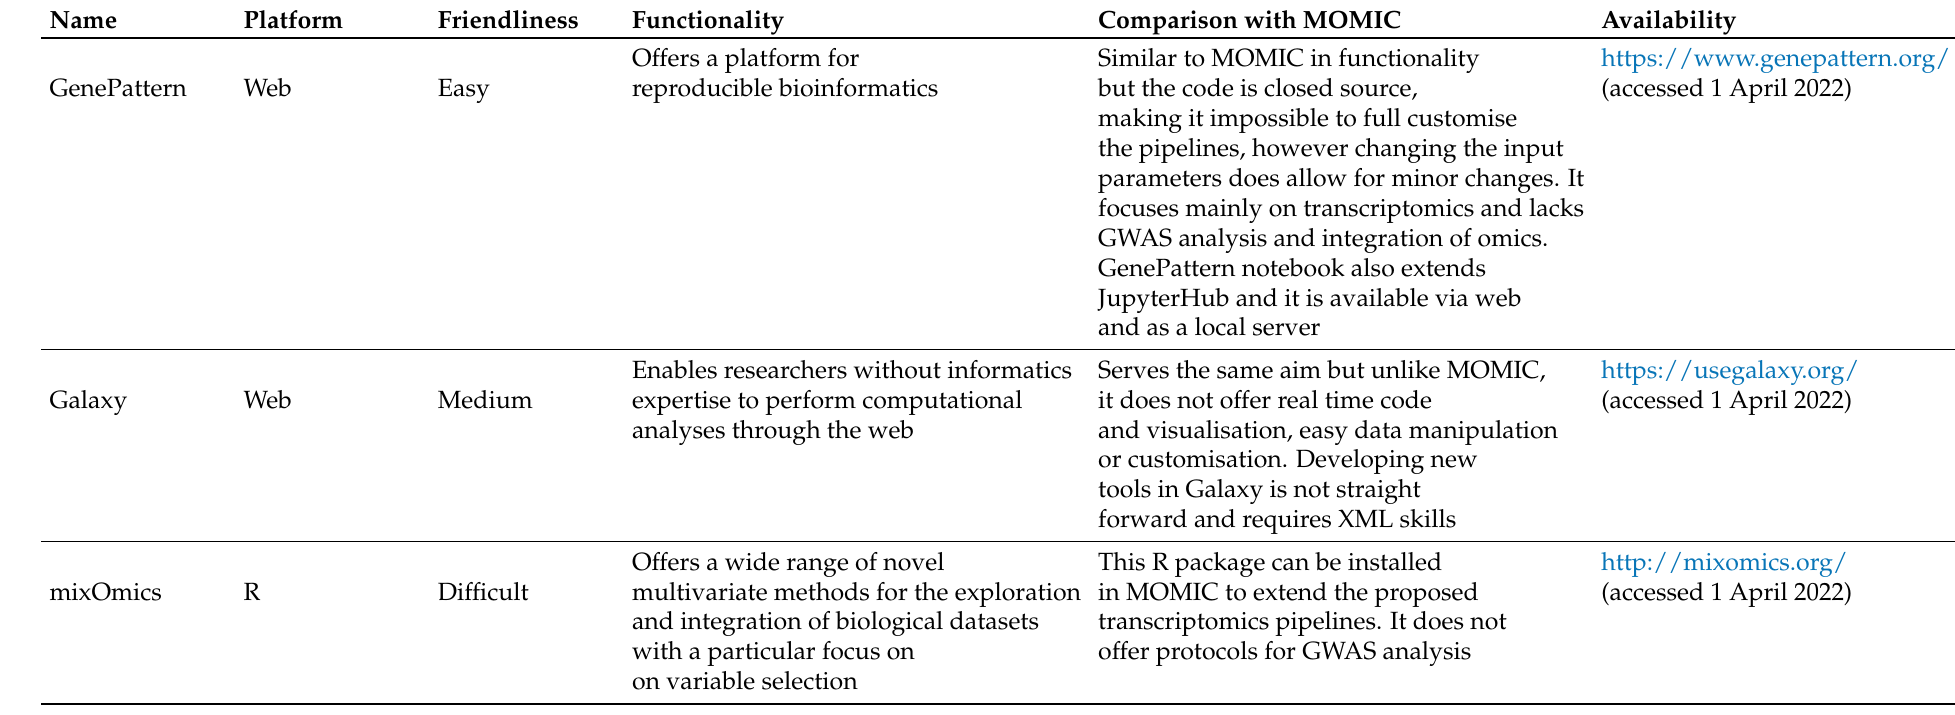
Table 1. Comparison of existing tools for omic